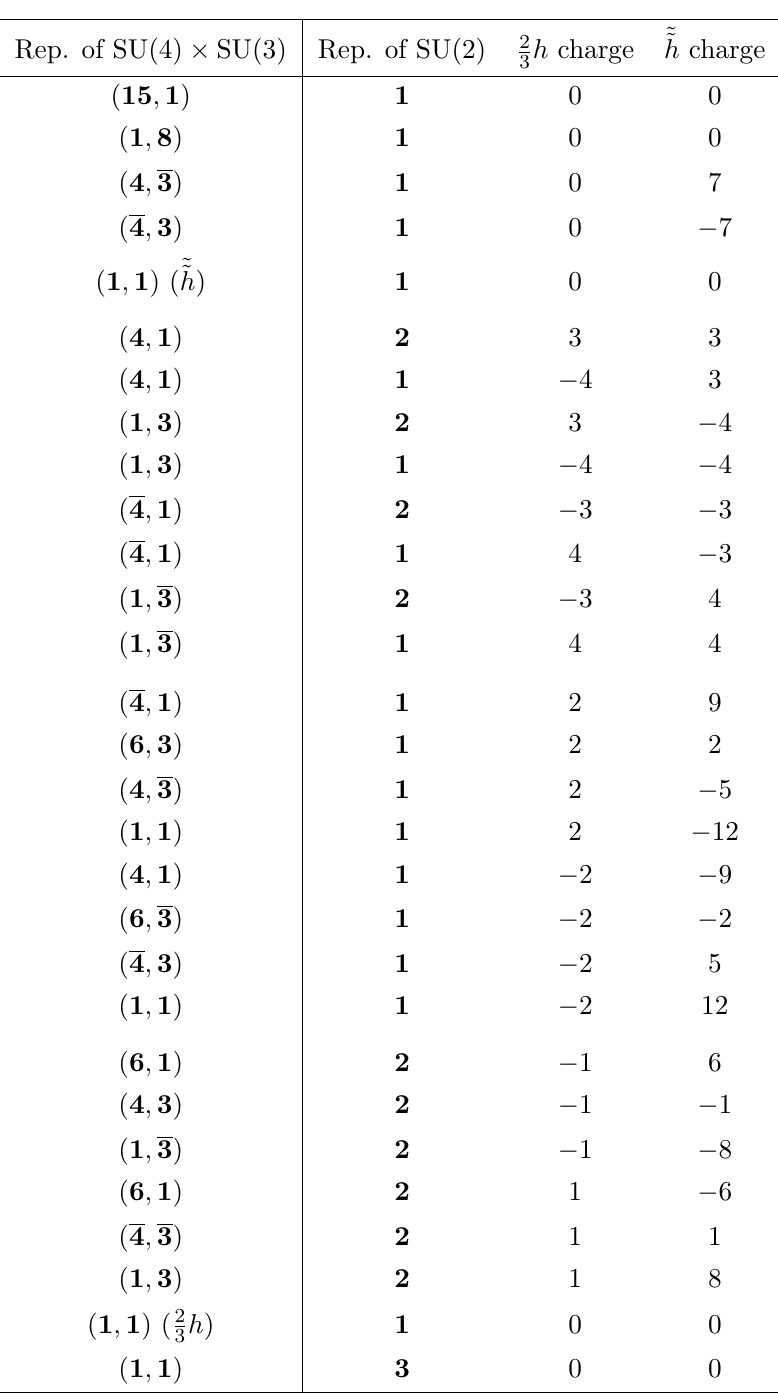
Table 11 . Decomposition of 248